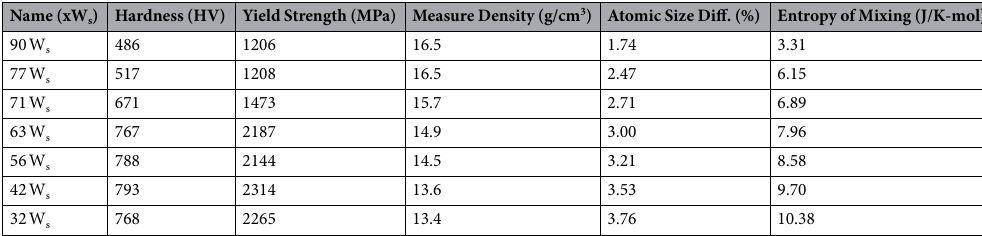
Table 2. Summarized physical and mechanical behavior with the thermodynamic properties of xW s sintered at 1600 o